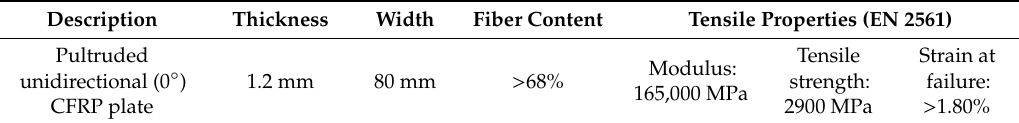
Table 1. Typical properties of the CFRP plates used in the present